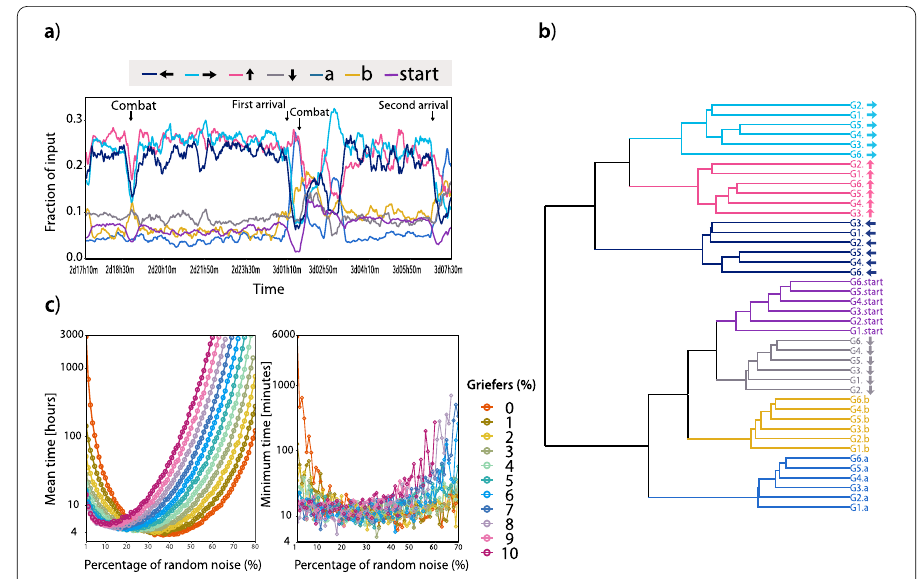
Figure 4 Study of the Ledge event. ( a ) Time evolution of the fraction of commands sent each minute. Note that a single player should be able to finish this area in a few minutes, but the crowd needed 15 hours. The time series has been smoothed using moving averages. ( b ) Hierarchical clustering of the time series of each group of users (see main text for details). ( c ) Left: Mean time needed to exit the area according to our simulations as a function of the fraction of griefers in the system and the noise in it. Right: 1% quantile of the time needed to exit the area, note that the y axis is given in minutes instead of